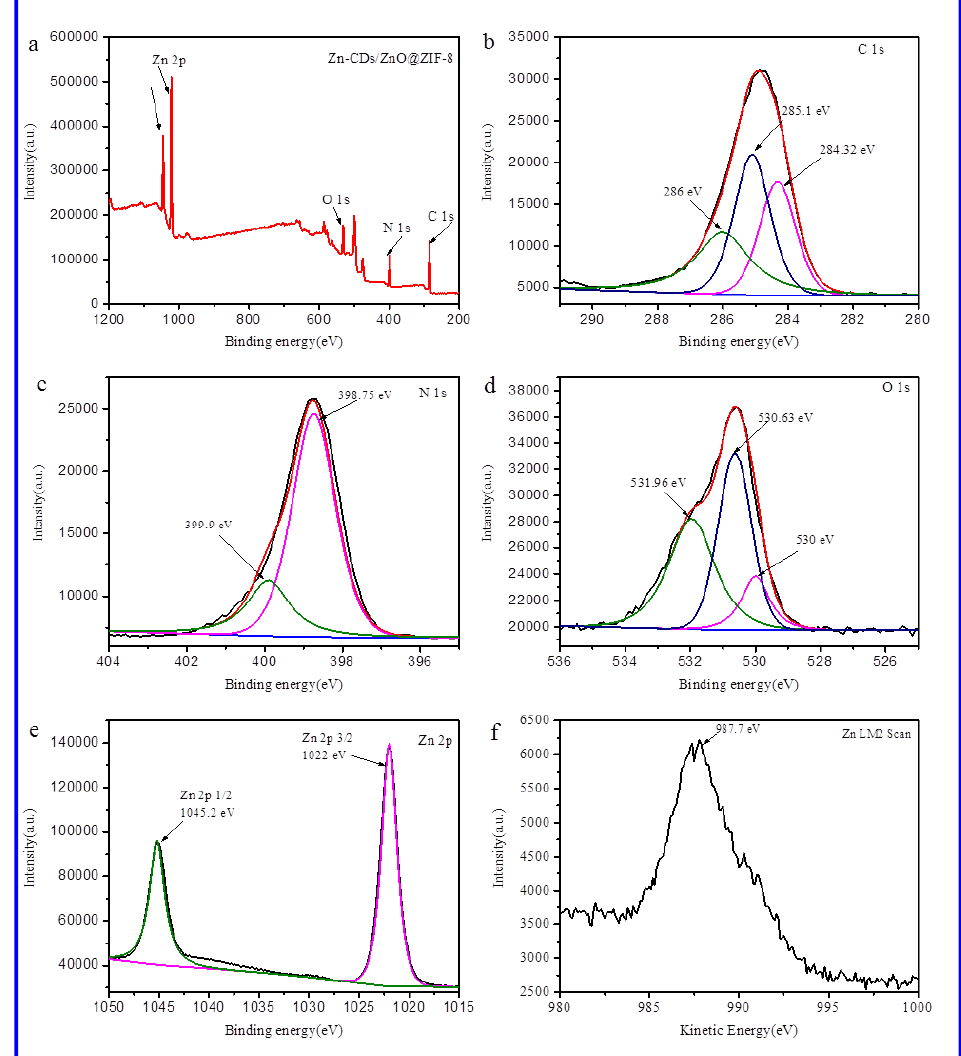
Figure 4. ( a ) Survey scan ( b ) C 1 s ( c ) N1 s ( d ) O 1 s ( e ) Zn2p of XPS and ( f ) Zn LM2 Scan Auger peak of ZnCDs/ZnO@ZIF-8.